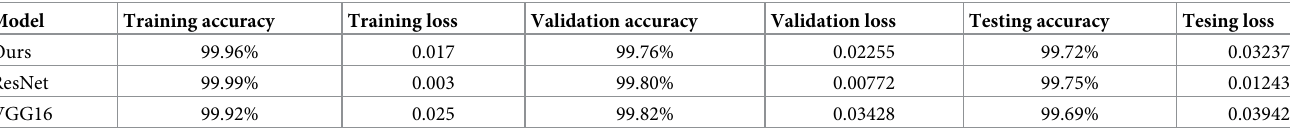
Table 16. The performance of each neural